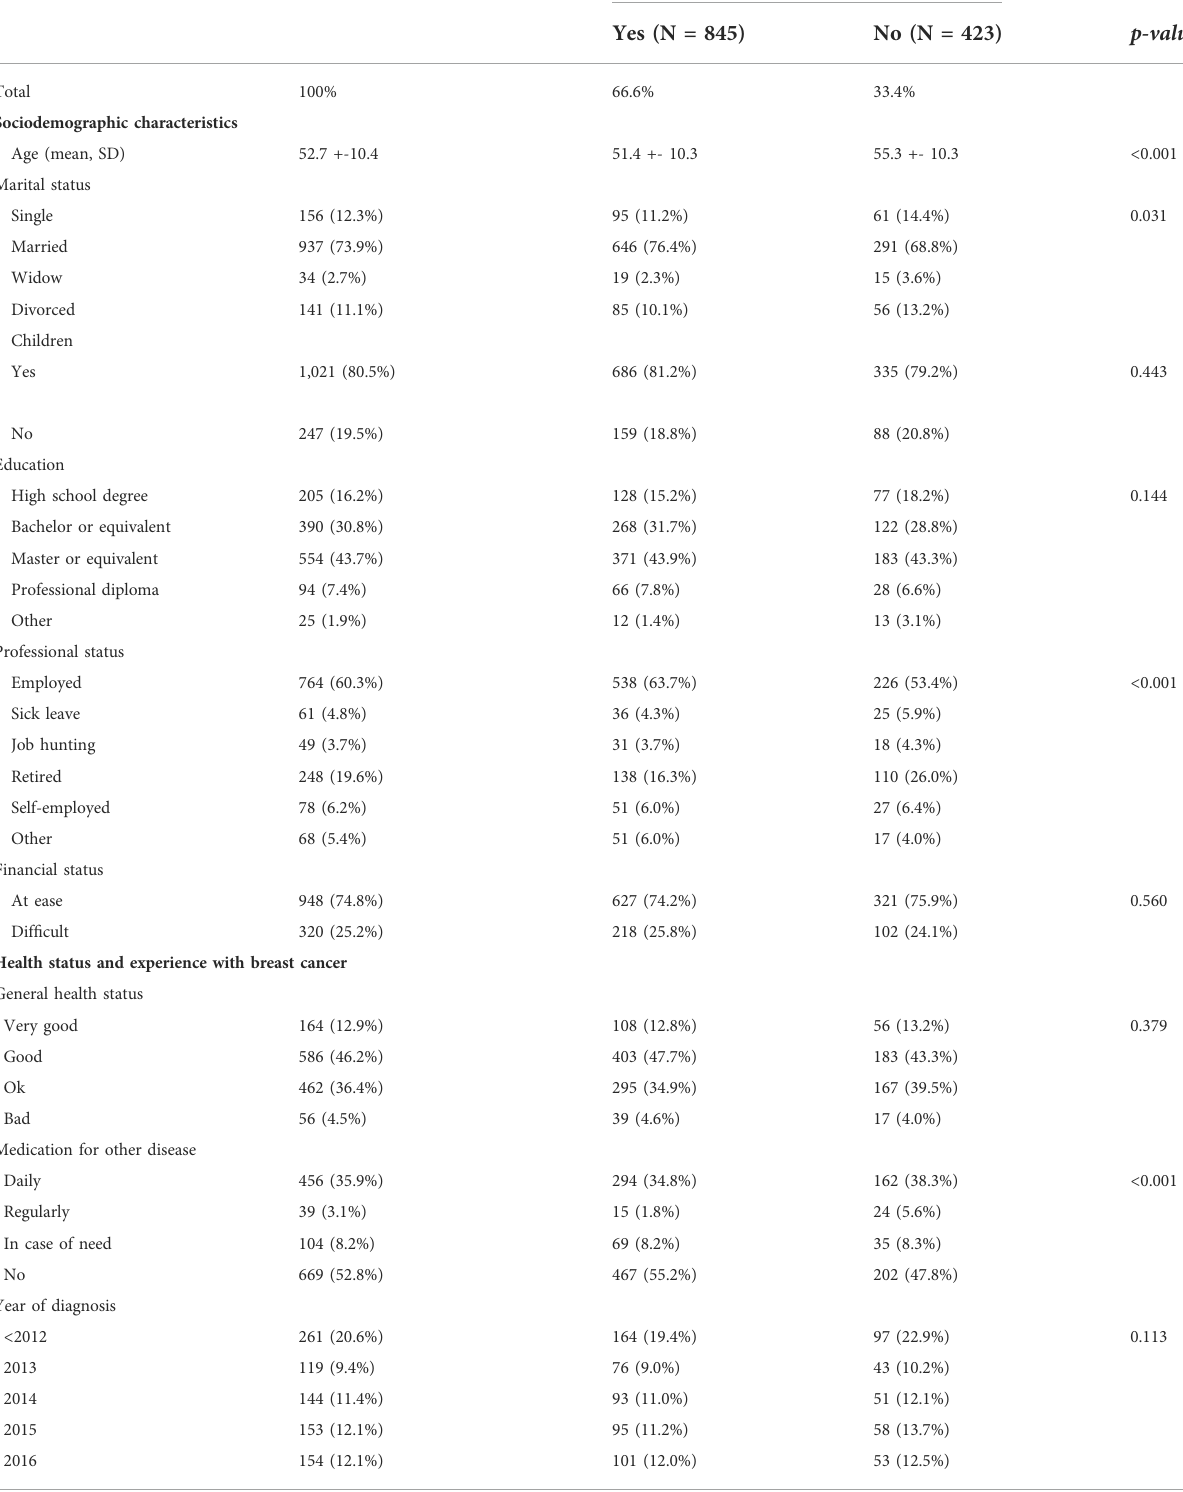
TABLE 1 Descriptive characteristics of BCS (Seintinelles study,